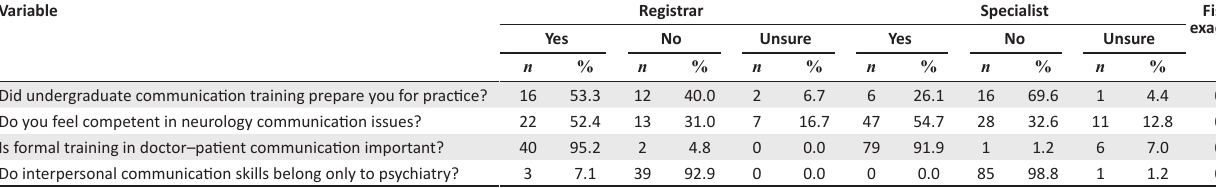
TABLE 3: Opinions relating to communication training during registrar training. Variable